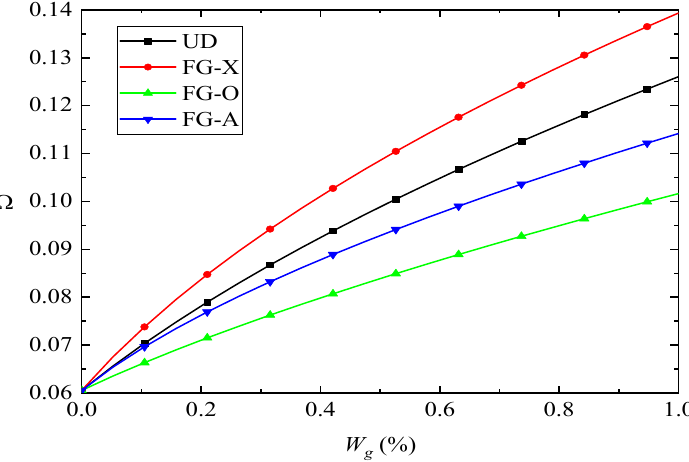
Figure 5. Effects of GPL weight fraction on the fundamental frequency of C-C FG-GPLRC circular arch ( θ 0 = π/3, λ = 1/10).